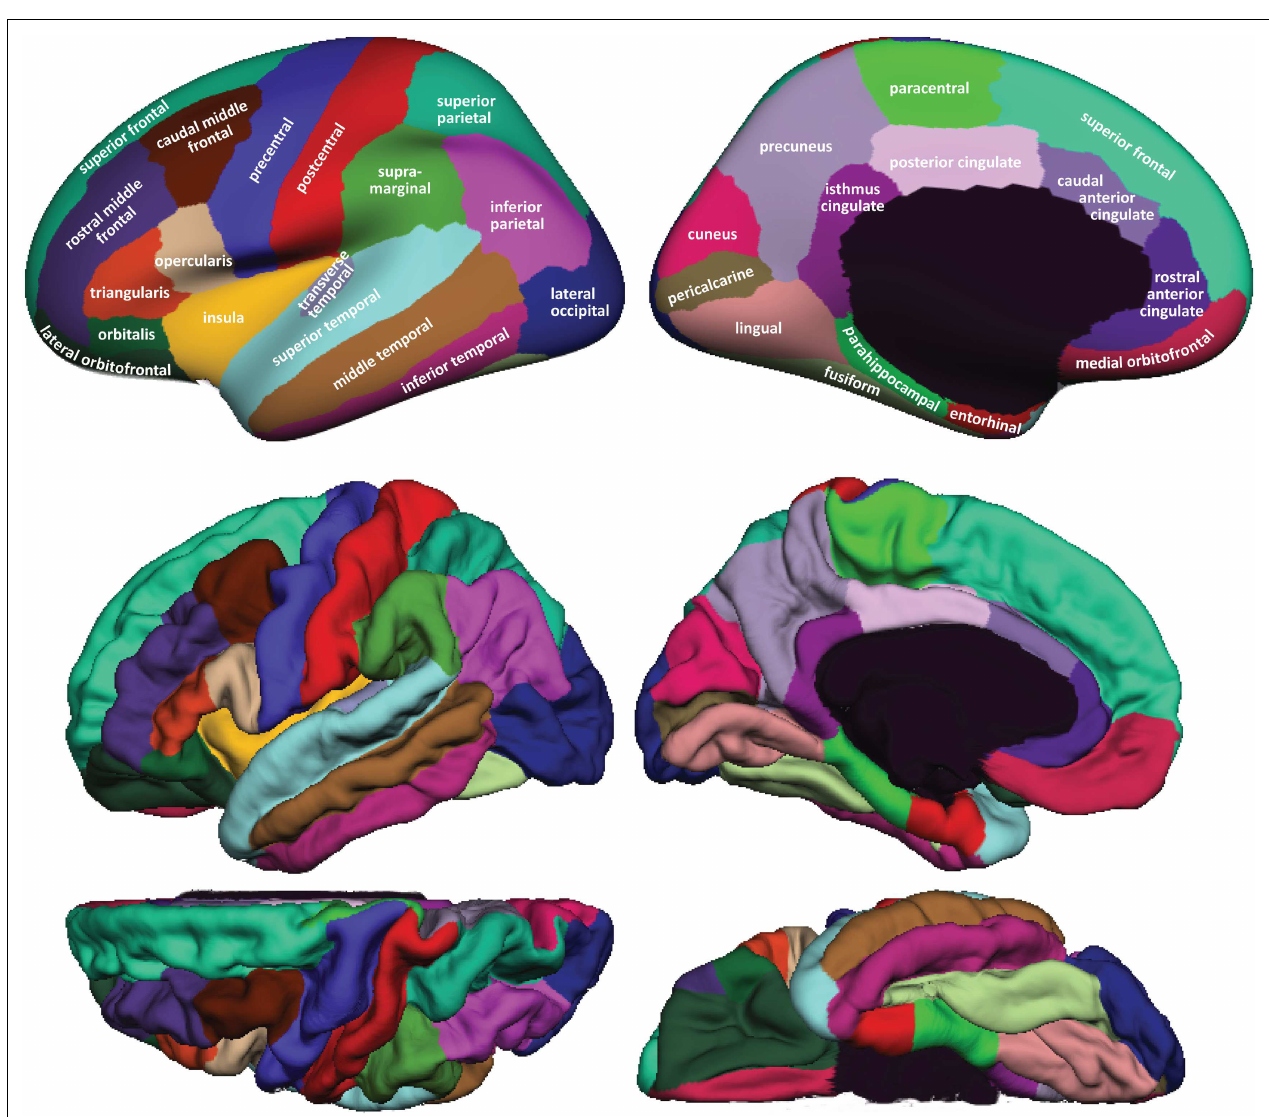
lateral (upper left), medial (upper right), dorsal (lower left), and ventral (lower right) views of the pial surfaces.The surface was automatically labeled with the DKT40 classifier atlas then manually edited as needed.The “fsaverage” data are included in the FreeSurfer distribution in $FREESURFER_HOME/subjects/fsaverage and the DKT-labeled version is available at